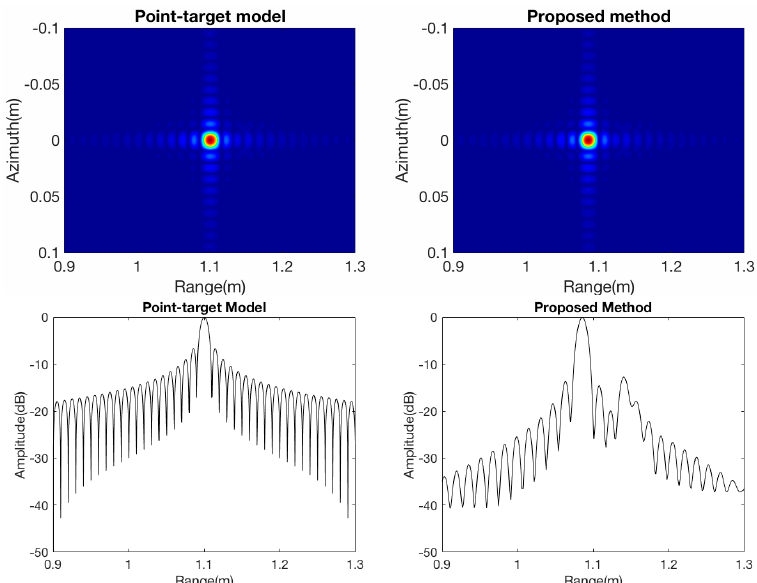
Figure 4. Comparison of focused images between the point-target model and the proposed method: Top row ( left : point-target model and right : proposed method); bottom row : range profile ( left : point-target model; right : proposed method).